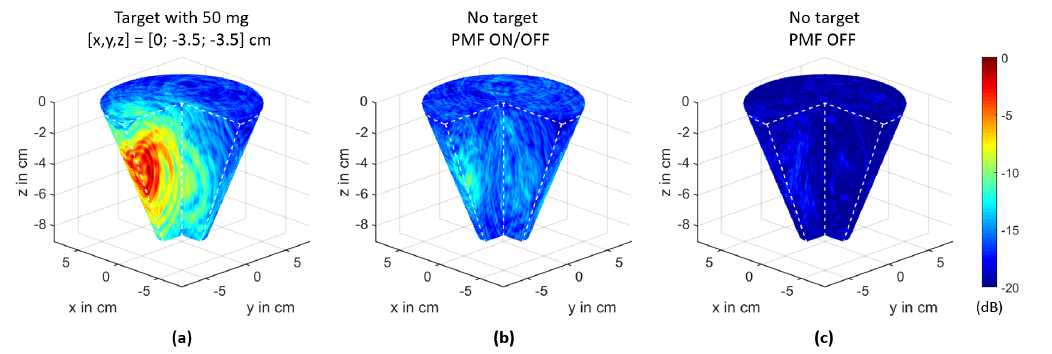
( t , ∆ H ) (see Figure 4c) as the m ,0 ONOFF